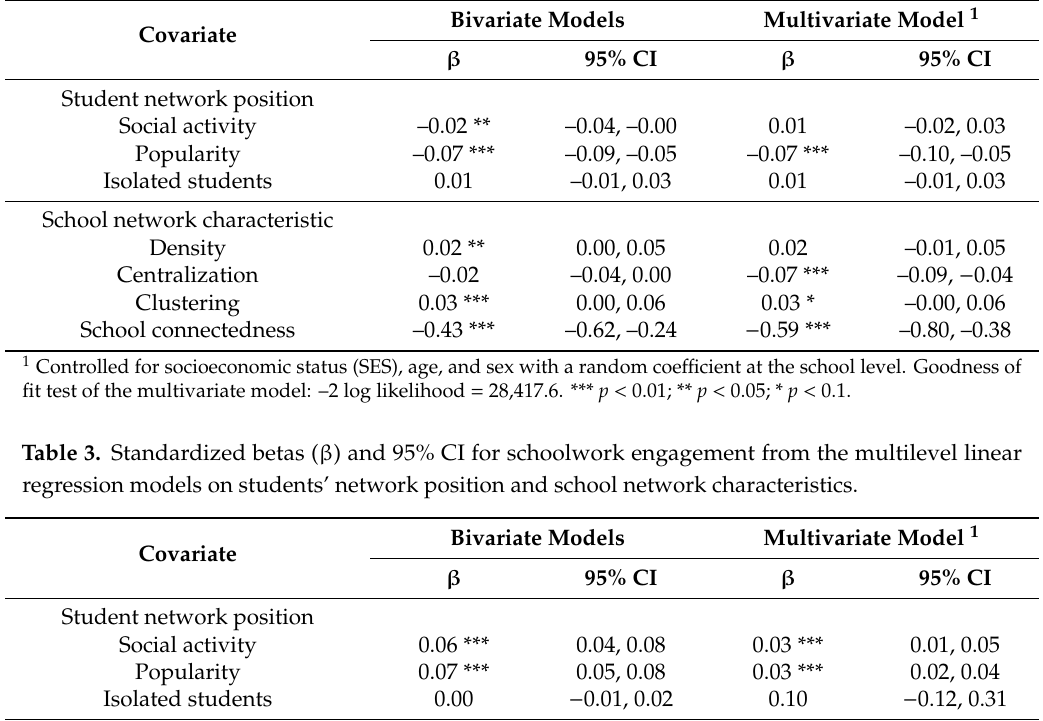
Table 2. Standardized betas ( β ) and 95% CI for school burnout from the multilevel linear regression models on students’ network position and school network characteristics.